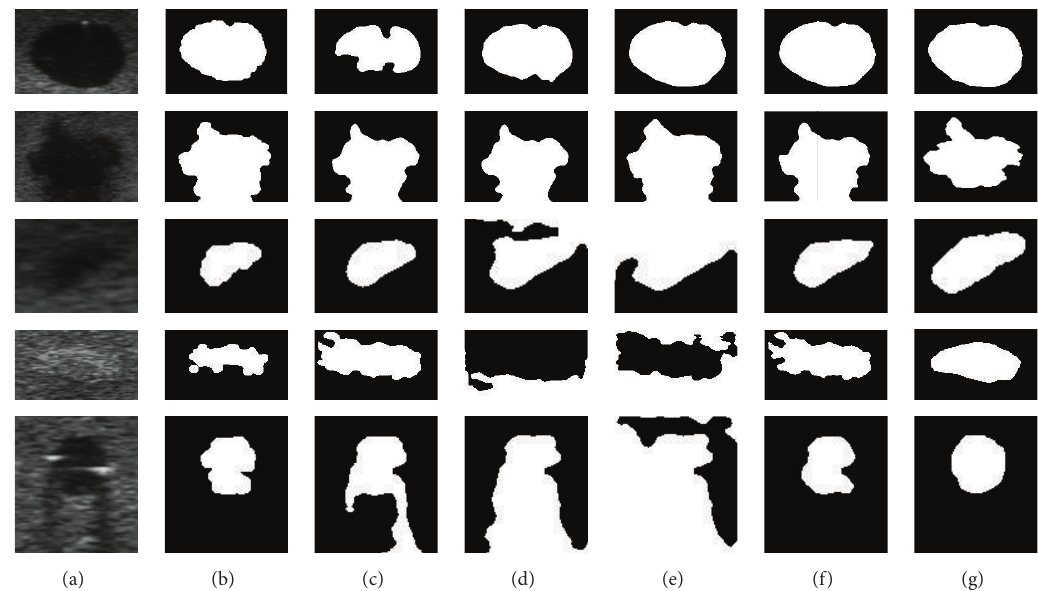
Figure 7: Results from tests with phantom images: (a) original ROI; segmentations by (b) active contour, (c) region growing, (d) fuzzy 𝑐 -means, (e) 𝑘 -means, (f) SOM, and (g) the radiologist delimitation.